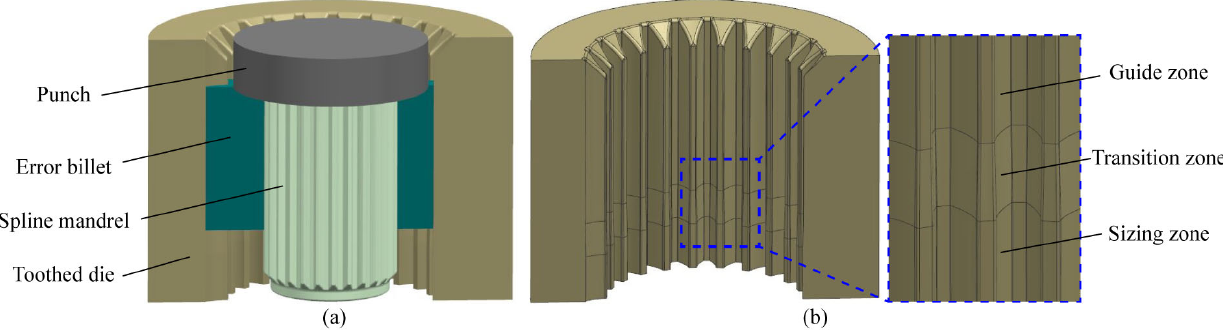
Figure 3. Precision finishing process of inner ‐ outer teeth [21]: ( a ) Assembly diagram and ( b ) toothed die structure.